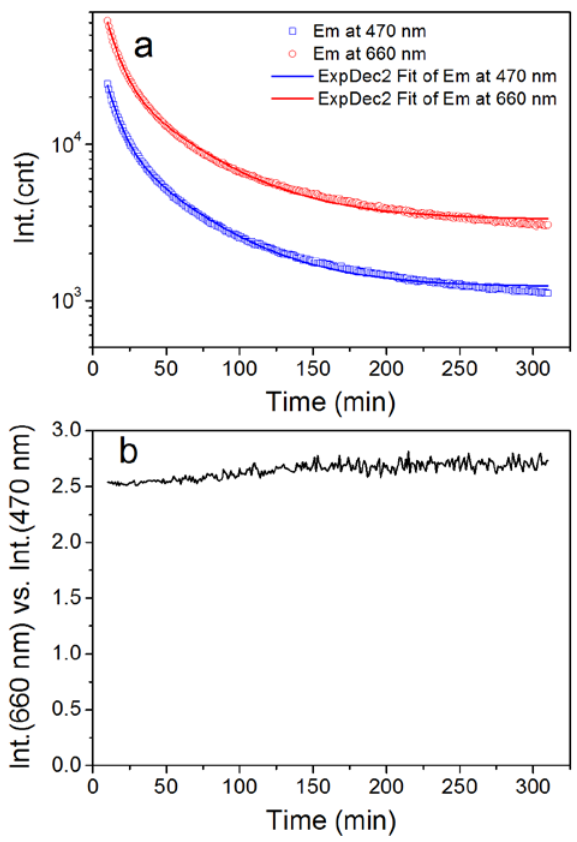
Figure 3. Afterglow emission of SMS and CASN/SMS nanocomposite PMMA (polymethyl methacrylate) film (20% of CASN by weight). Samples are excited by using a violet LED torch (395 nm, 9 w).